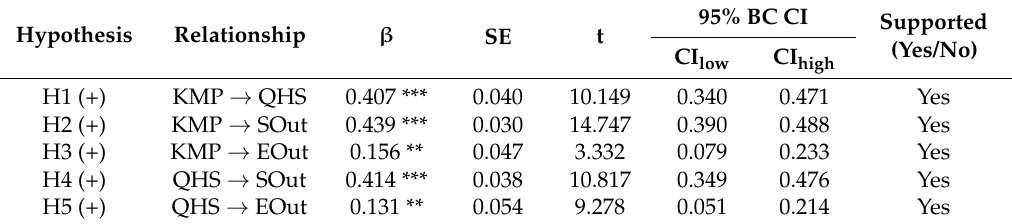
Table 5. Testing for direct effects.